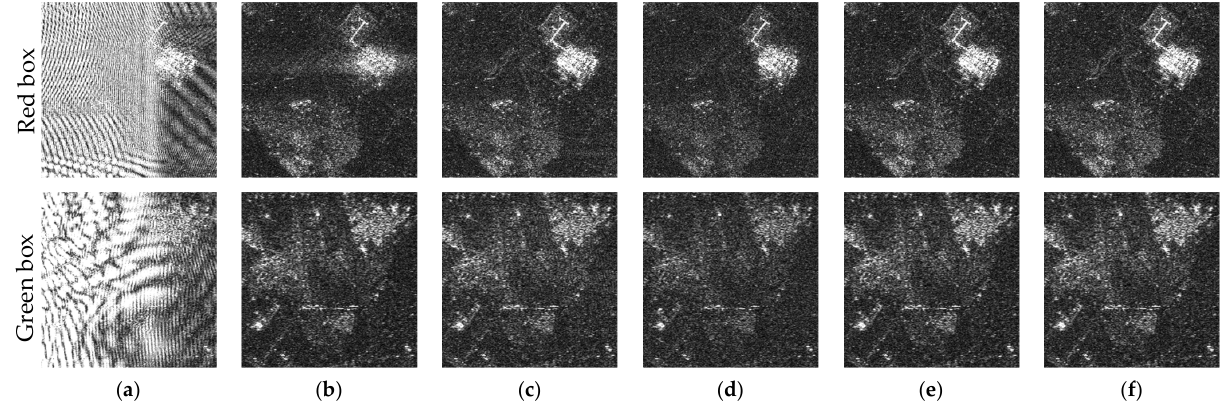
Figure 21. Comparison of the enlarged areas in Figure 20: (Row 1) the red box region; (Row 2) the green box region. ( a ) The RFI-free SAR image, ( b ) ISNF, ( c ) ESP, ( d ) GoDec, ( e ) LRDS, and ( f ) TFC-LRS. Table 8. Performance comparison of RFI mitigation algorithms for the measured WBI-corrupted SAR data.